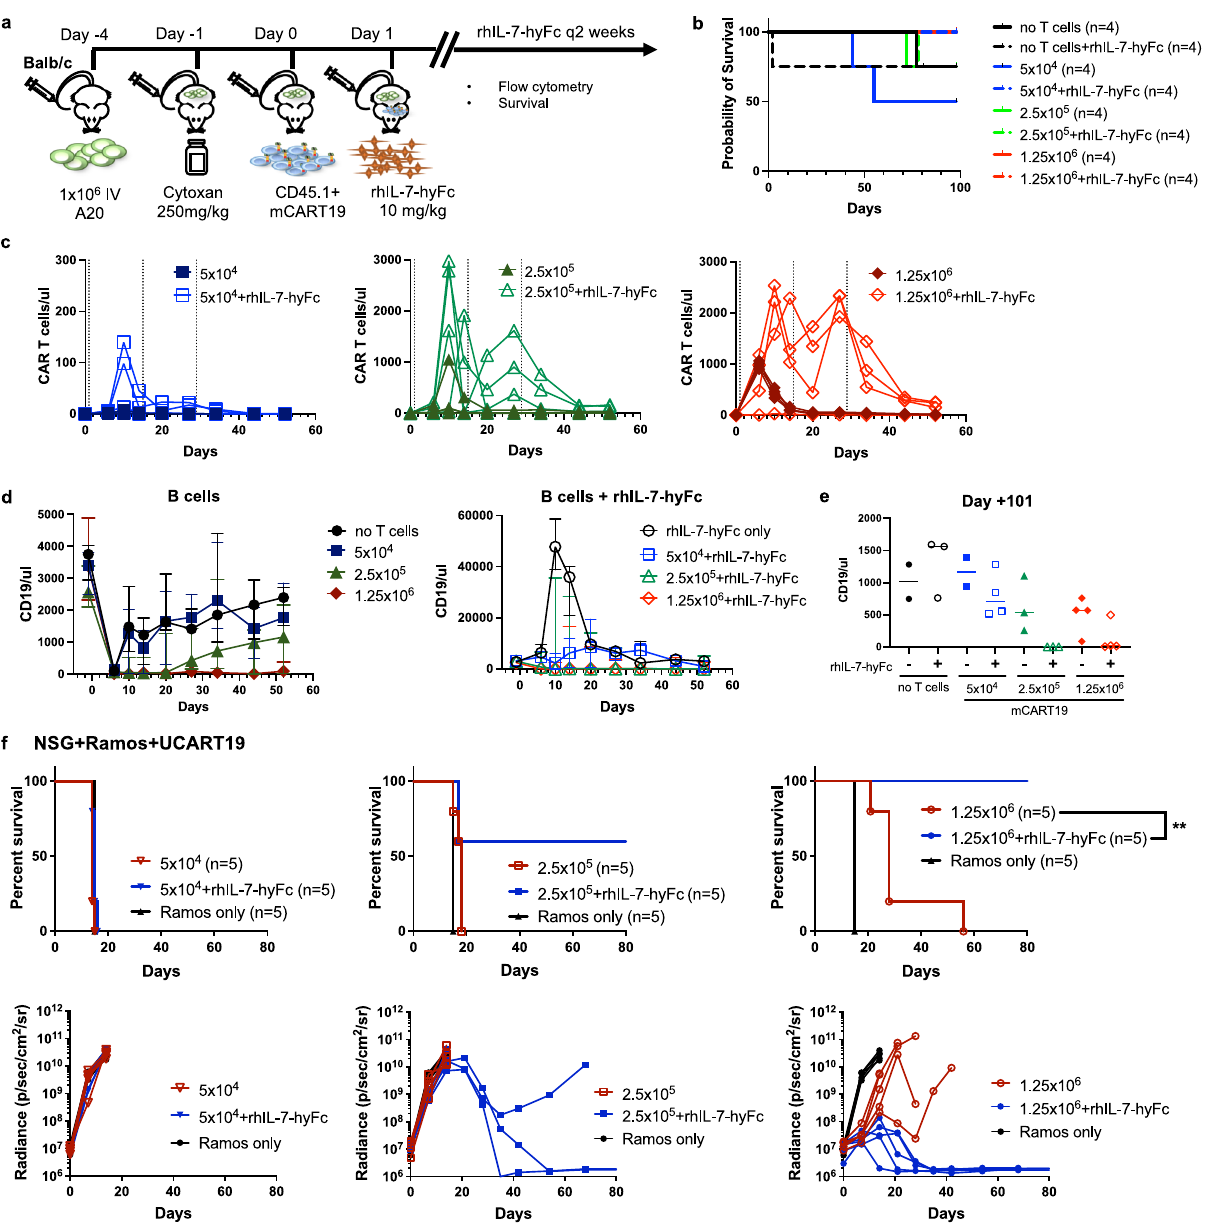
Fig. 6 rhIL-7-hyFc reduces the number of CAR T cells required for the biological effect. a – e Balb/c mice were fi rst given 1 × 10 6 A20 tumor cells, followed by cyclophosphamide (Cytoxan) conditioning 1 day prior to receiving mCART19 (5 × 10 4 , 2.5 × 10 5 , or 1.25 × 10 6 cells per mouse), then given serial injections of rhIL-7-hyFc on days + 1, + 15, and + 29 ( n = 4/group). b Overall survival of mice for all groups. c Peripheral blood CAR T cell expansion was measured over time by quanti fi cation of CD45.1 + GFP + cells. Each line represents values from one mouse. d B cell numbers were measured over time by quanti fi cation CD45.2 + CD19 + cells. Data represented as median ± range. Note that 5 × 10 4 cells (left panel) are depicted on a different scale. e B cell numbers on day + 101 after T cell injection. f NSG mice were injected with 5 × 10 5 Ramos CBR-GFP followed by UCART19 treatment (5 × 10 4 , 2.5 × 10 5 , or 1.25 × 10 6 cells per mouse) with serial injections of rhIL-7-hyFc on days + 1, + 15, and + 29 ( n = 5 mice per group). The top panels represent overall survival, while the bottom panels show serial tumor burden measurements (each line represents one mouse). p Values were calculated using two-sided Wilcoxon test (UCART19 1.25 × 10 6 + rhIL-7-hyFc vs. UCART19 1.25 × 10 6 only, p = 0.0039). Source data are provided as a Source data fi le. ** p ≤